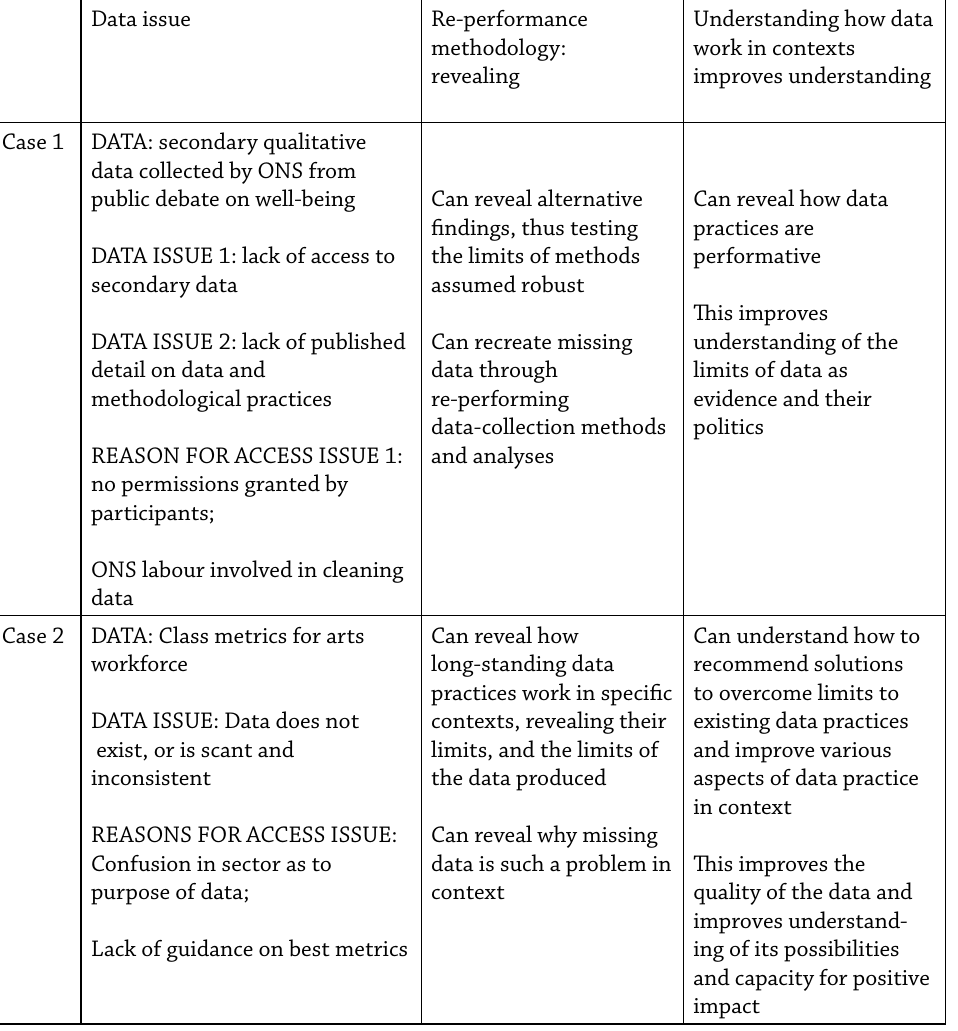
Table 3: The benefits of a re-performance approach. Data issue Re-performance